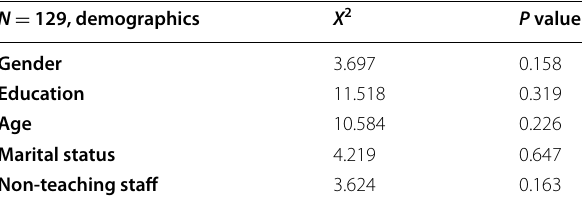
Table 5 Association between awareness of stroke risk factors and the demographics of respondents